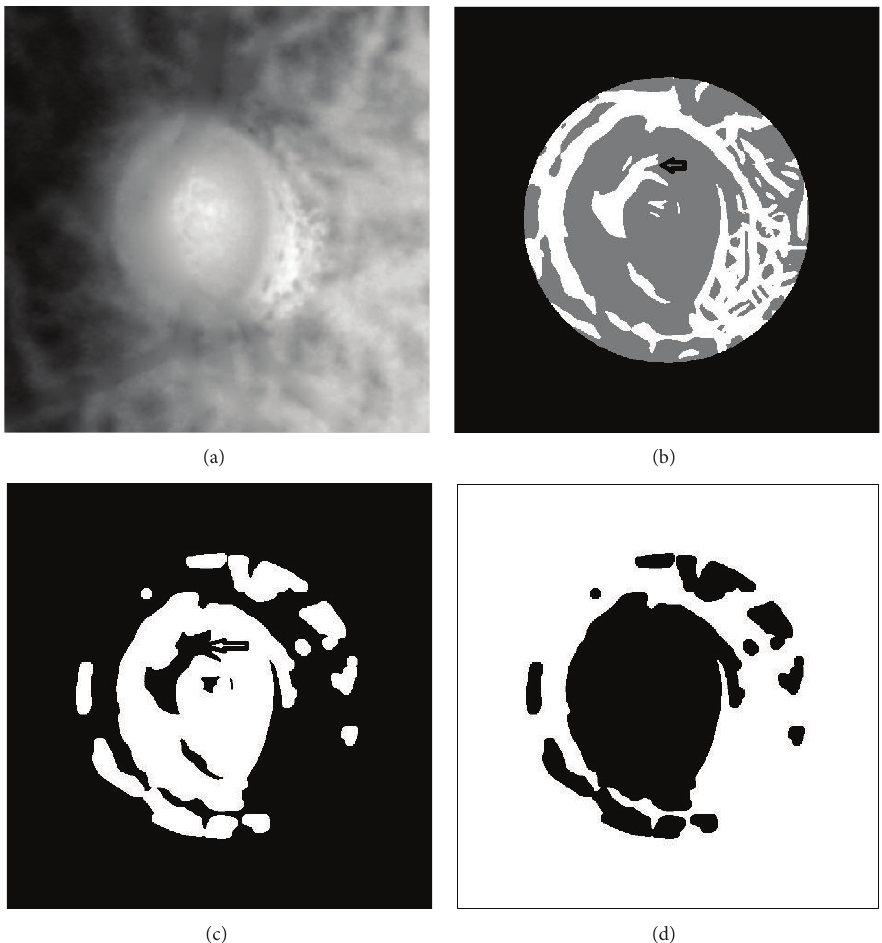
Figure 10: Edge region selection steps. (a) Raw image. (b) After fuzzy c means cluster. (c) After open operation. (d) Edge region. the estimated edge region from the texture image by fuzzy 𝑐 means approach. The detail of operation is as